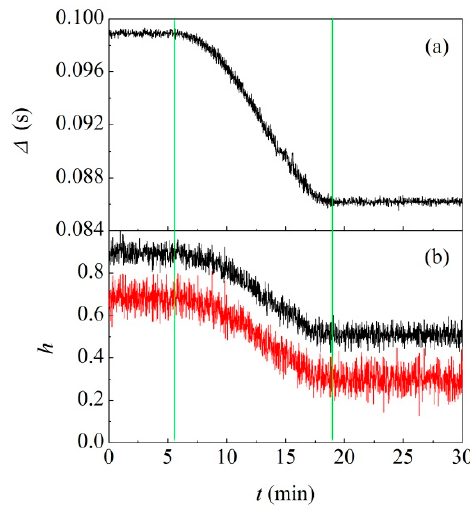
Figure 5. The transition in milling dynamics. ( a ) The distance, ∆ , between consecutive signals and ( b ) the relative intensity, h , of signals due to impacts on the bottom base (black) and the vial cap (red). The two vertical green lines mark the transition period.